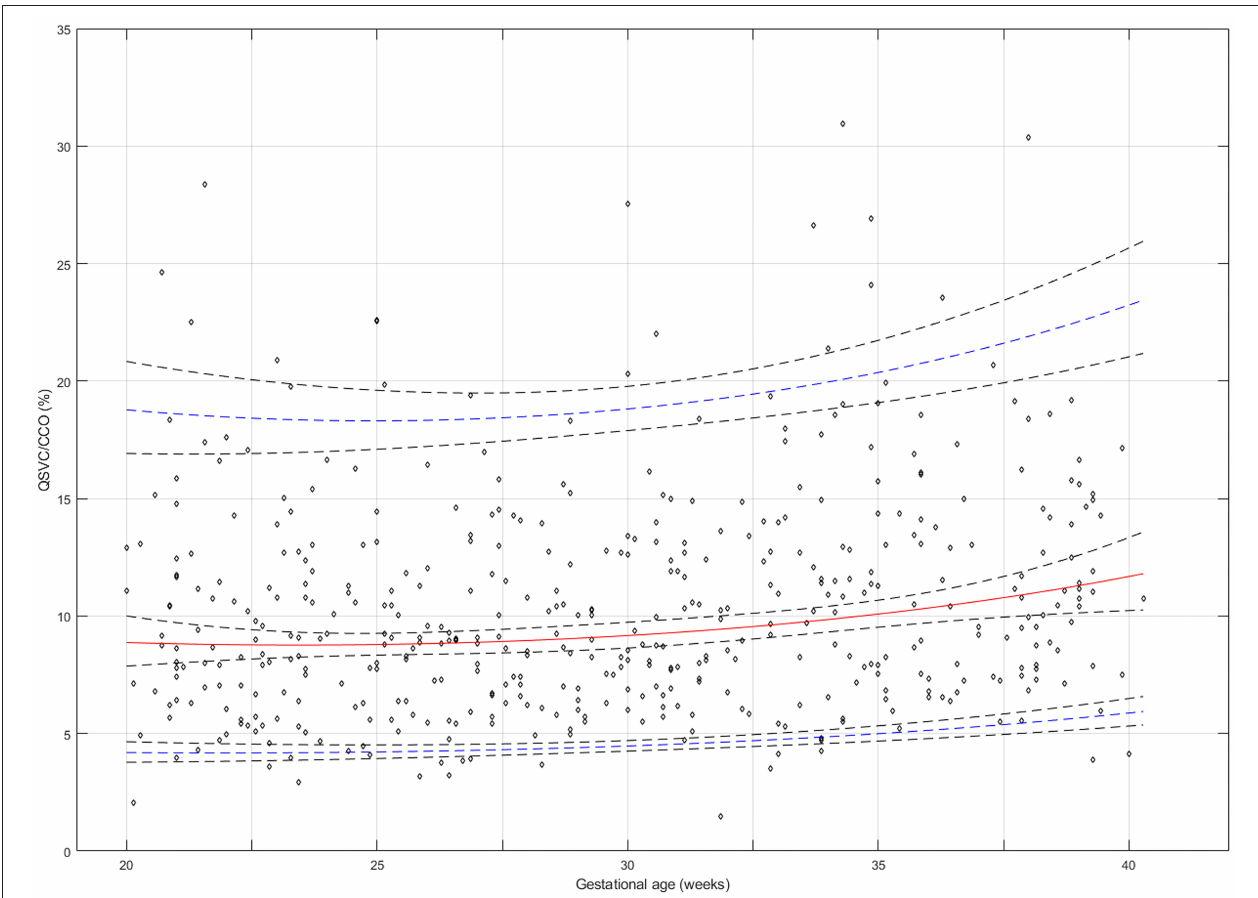
FIGURE 4 | Reference chart for the superior vena cava (SVC) fraction (%) of fetal combined cardiac output (CCO) distributed to the brain and upper body at 20–40 weeks of gestation. The solid red line represents the 50th percentile, the blue lines represent the 5 and 95th percentiles and the interrupted black lines represent their respective 95% confidence